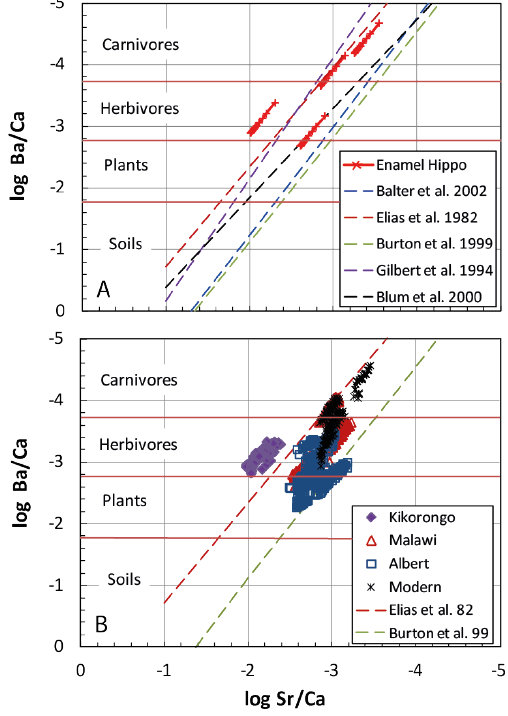
Fig. 5. Trophic levels in different ecosystems as defined by the Sr/Ca and Ba/Ca variation in bones and teeth. The ranges of Ba/Ca defining the trophic levels are from (Balter et al., 2002). (a) Com- pilation of published Sr/Ca and Ba/Ca values representing different ecosystems. The dashed lines represent regression lines of data cov- ering several trophic levels in single ecosystems or represent aver- ages summarizing several ecosystems. Red lines with crosses show crystallization models of the variation of Sr/Ca and Ba/Ca in enamel from hippopotamids of this study as shown in Fig. 4. Note that the slope of the variation of enamel is similar to that observed in ecosys- tems. Data sources are given in the legend. (b) Variation of Sr/Ca and Ba/Ca in enamel of hippopotamids teeth analyzed in this study. Enamel displays a large range which extends from the field of her- bivore well into the fields of carnivores and